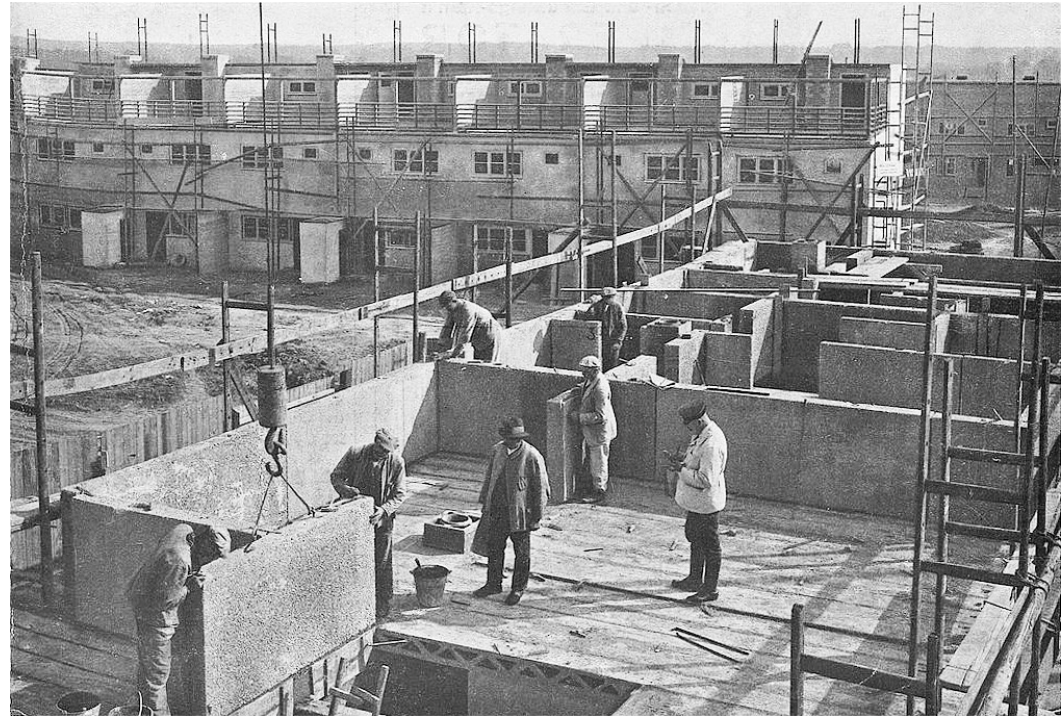
Figure 3. Ernst May: “Frankfurter Montageverfahren” (‘Frankfurt assembly method’). Photo from Das Neue Frankfurt , 1926/1927/2, title.